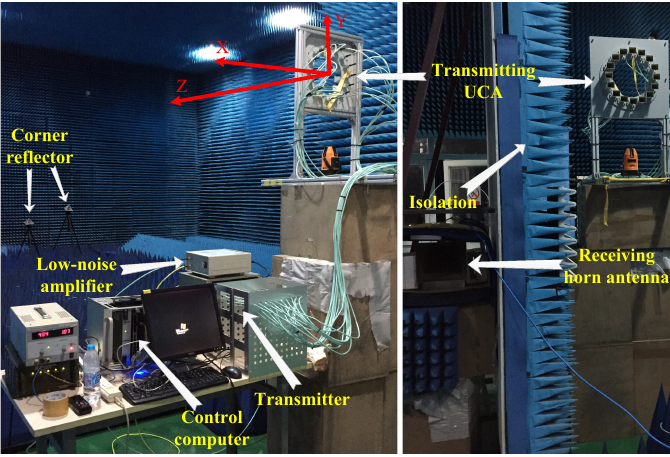
Figure 6. Measurement setup in an anechoic